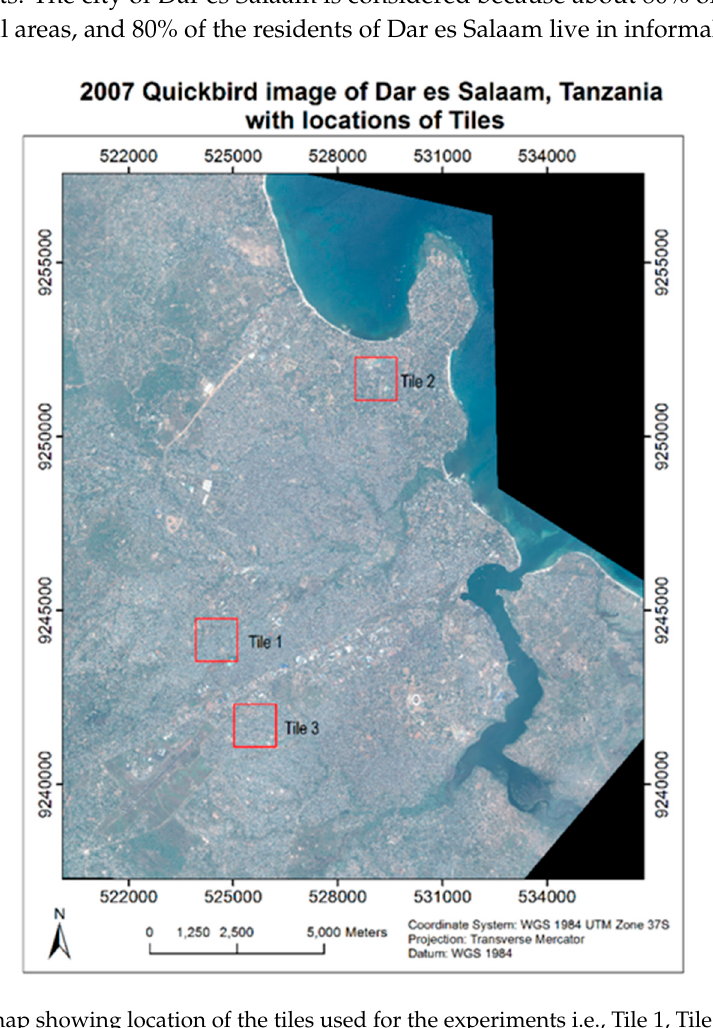
Figure 3. A map showing location of the tiles used for the experiments i.e., Tile 1, Tile 2 and Tile 3.